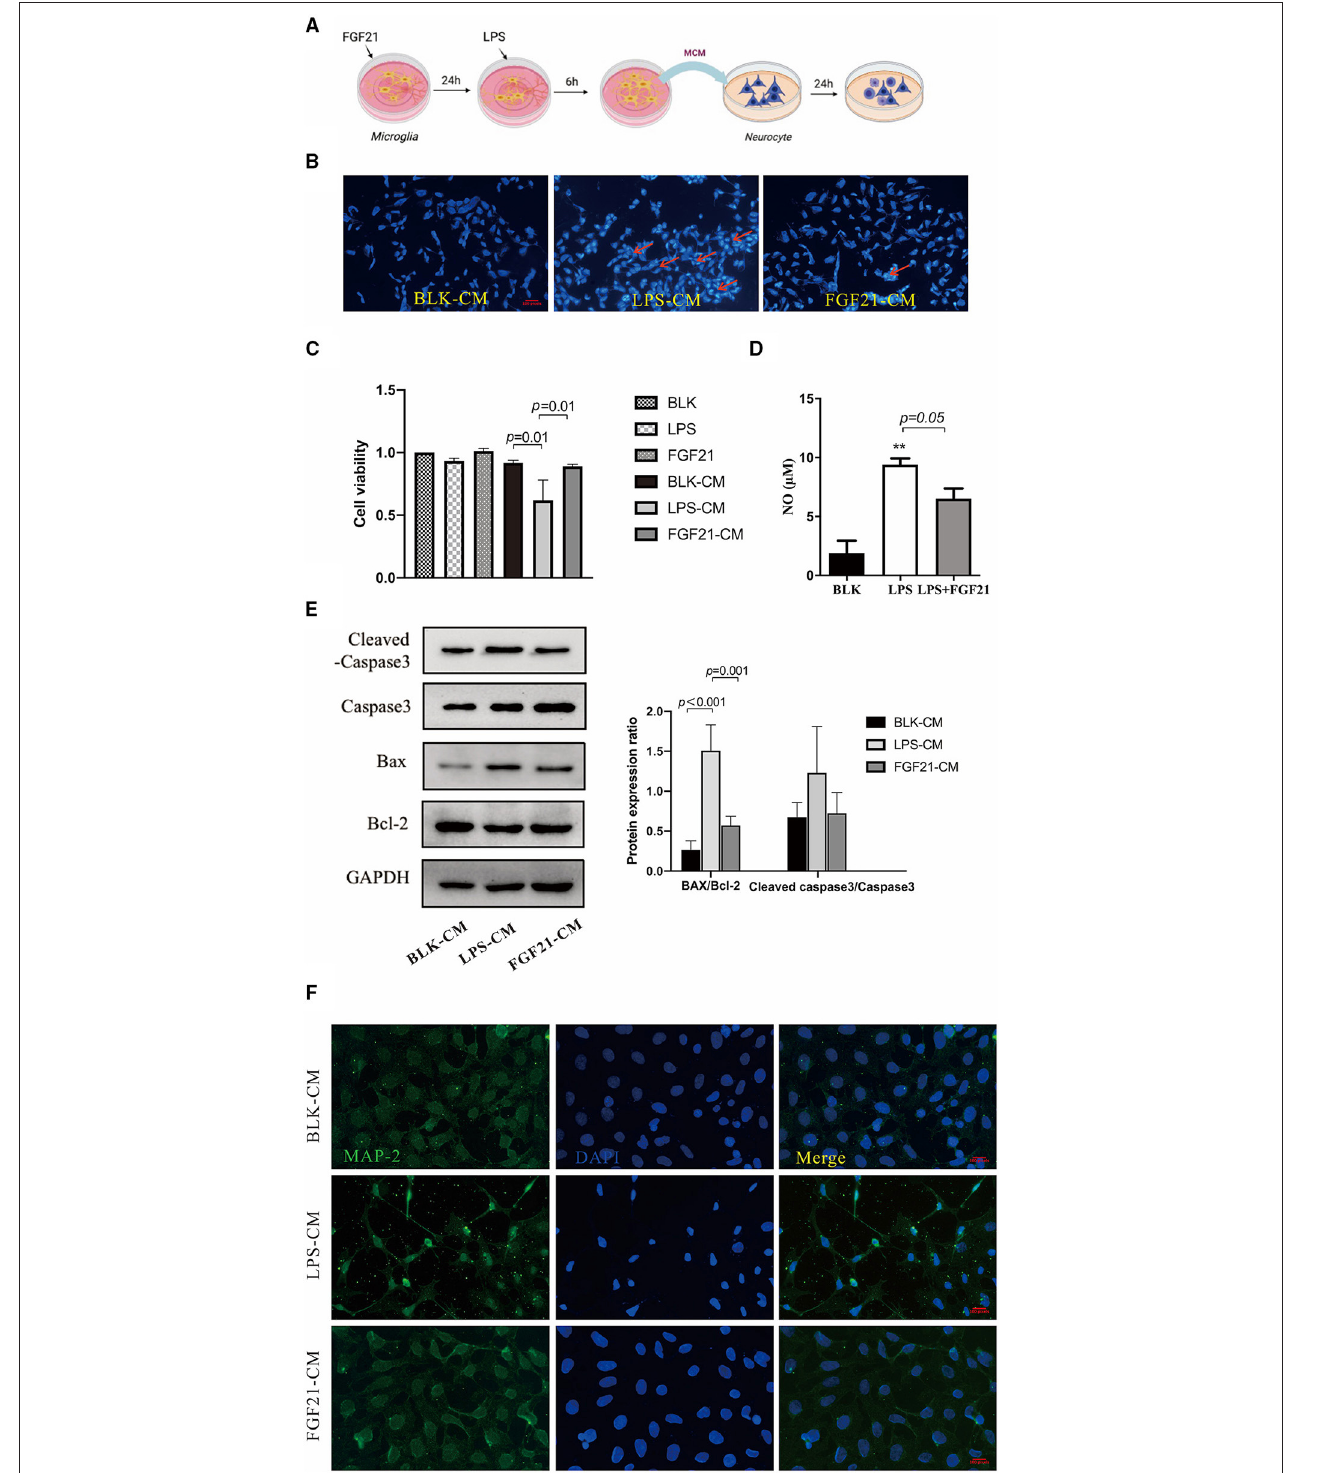
FIGURE 7 | FGF21 protects against neuronal apoptosis in a microglia-dependent manner. (A) Treatment neurons with conditioned medium of microglia with or without FGF21 pre-treatment. (B) Representative images of Hoechst 33342 staining of SH-SY5Y treated with LPS-CM with vehicle or FGF21. Scale bar, 100 pixels. (C) Cell viability. (D) FGF21 pretreatment prevented the increase of NO in a microglia-conditioned medium. (E) MAP-2 (green) and DAPI (blue) immunostaining of SH-SY5Y cells. Scale bar, 100 pixels. (F) expression levels of Bcl-2, Bax, and cleaved caspase-3 in SH-SY5Y cells. Data are mean ± s.e.m, n = 3 samples. A one-way ANOVA data analysis was conducted followed by an LSD multiple comparison test. ** P < 0.01 vs. intact cells.